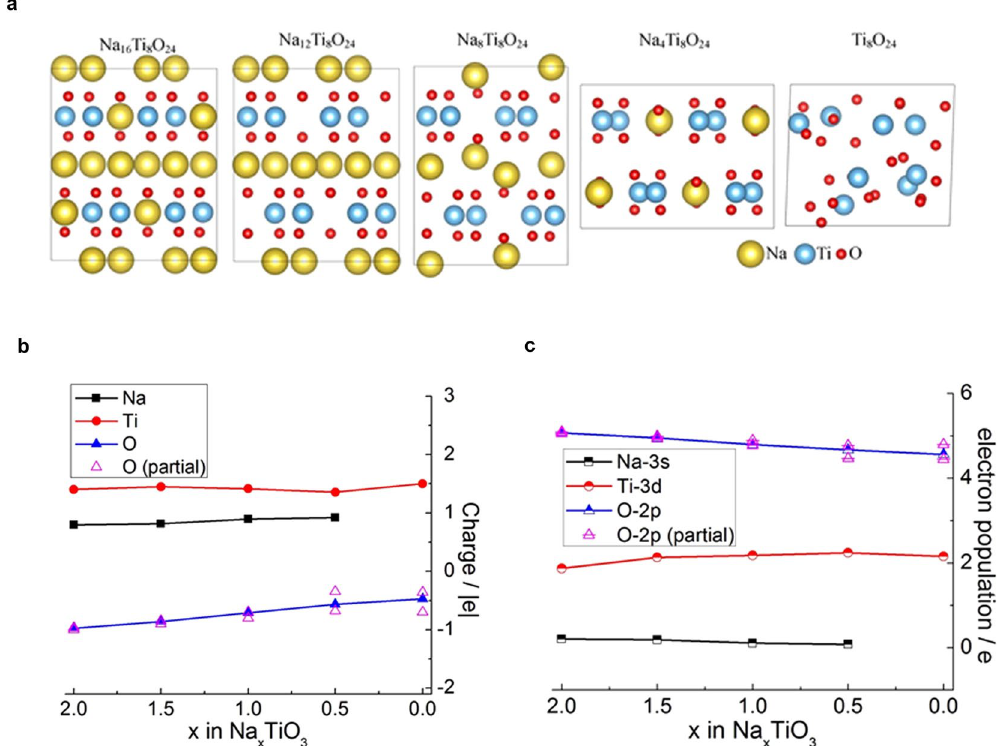
Figure 7. Density Functional Calculations for Na 2 TiO 3 . (a) Optimized structures of Na 16 Ti 8 O 24 , Na 12 Ti 8 O 24 , Na 8 Ti 8 O 24 , Na 4 Ti 8 O 24 and Ti 8 O 24 from left to right. ( b) Mulliken and ( c) Electron populations of the valence orbital of each element in Na 16 Ti 8 O 24 , Na 12 Ti 8 O 24 , Na 8 Ti 8 O 24 , Na 4 Ti 8 O 24 and Ti 8 O 24 which corresponds x = 2, 1.5, 1, 0.5, 0 in Na x TiO 3 respectively. The lines connect average populations of each orbitals in different concentrations. The magenta triangles show average populations of 2p orbitals of different types of oxygen atoms at each